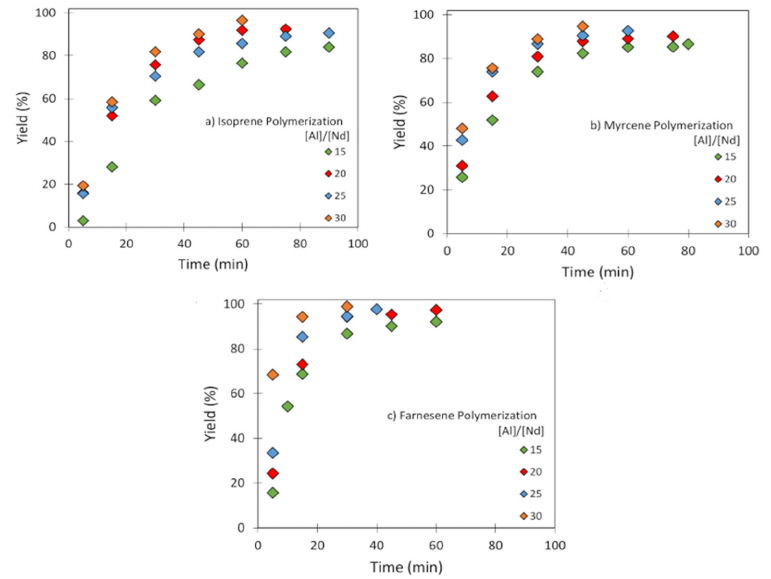
Figure 2. Conversion evolution as a function of time using different [Al]/[Nd] ratios for ( a ) Ip: entries Ip-3 to Ip-6; ( b ) My: entries My-3 to My-6; ( c ) Fa: entries Fa-3 to Fa-6, polymerizations initiated by NdV 3 /Al( i -Bu) 2 H/Me 2 SiCl 2 in cyclohexane at 60 ◦ C.